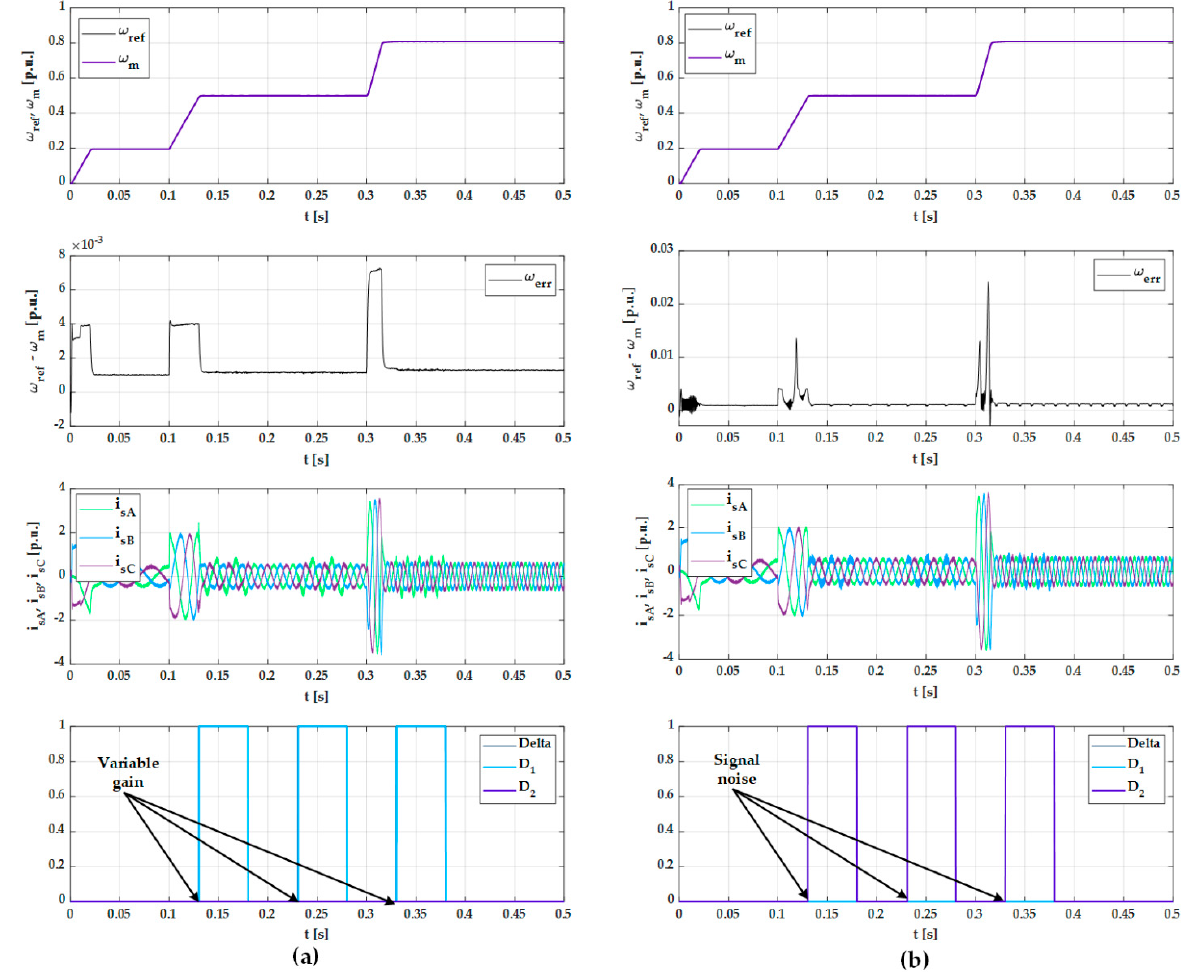
Figure 7. Detector responses and state variable transients during variable gain (1.2 i a ) ; in phase A ( a ) and measurement noise (20 dB) in phase B ( b ).